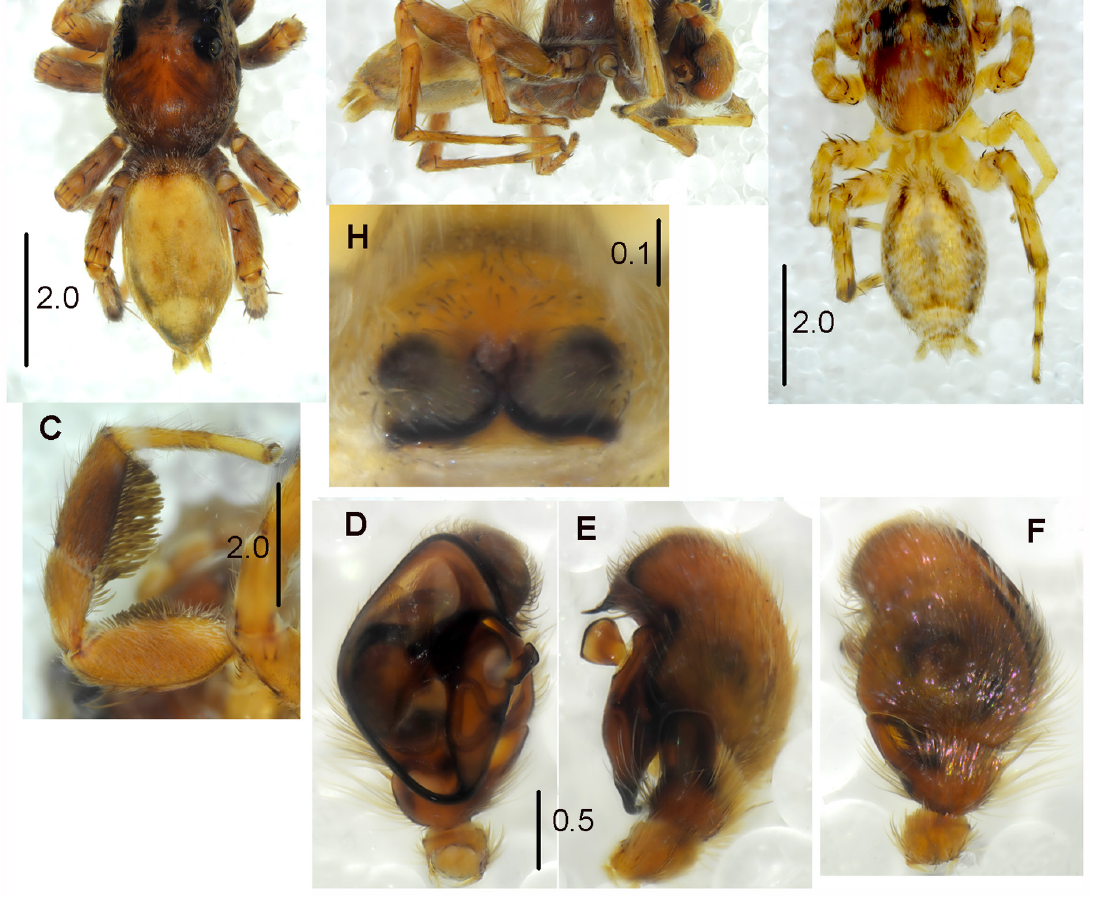
Fig. 61. Sonoita ledouxi sp. nov., paratypes, ♂♀ (MNHN). A . Habitus of male, dorsal view. B . Habitus of male, lateral view. C . First leg of male. D . Palpal organ, ventral view. E . Palpal organ, lateral view. F . Palpal organ, dorsal view. G . Habitus of female, dorsal view. H .